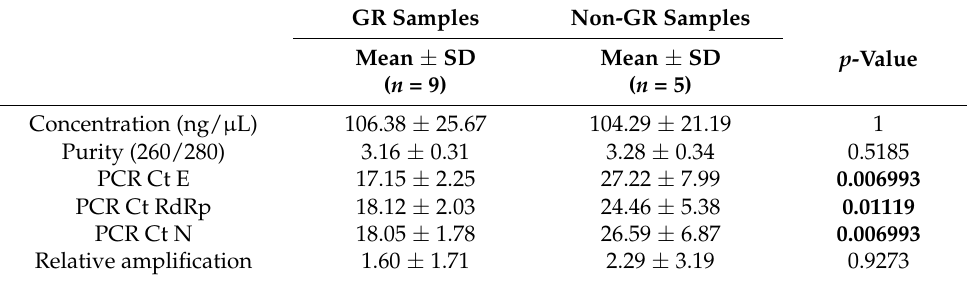
Table 5. Comparison of parameters between the GR samples and non-GR samples according to the SA-HRM